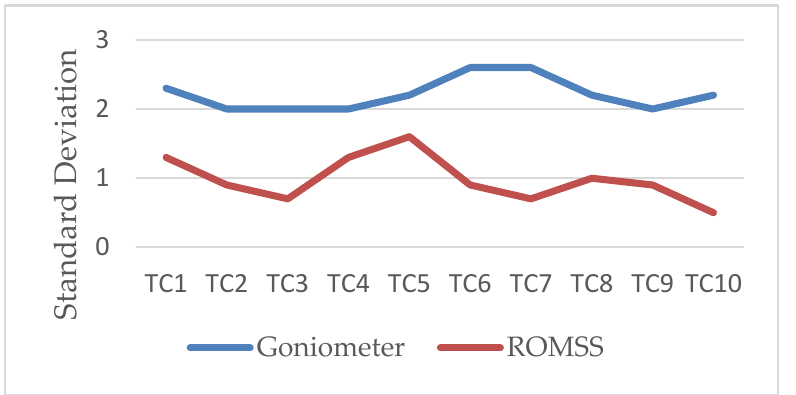
Figure 9. Standard deviation under the goniometer and the ROMSS in the simulated arm (test cycle